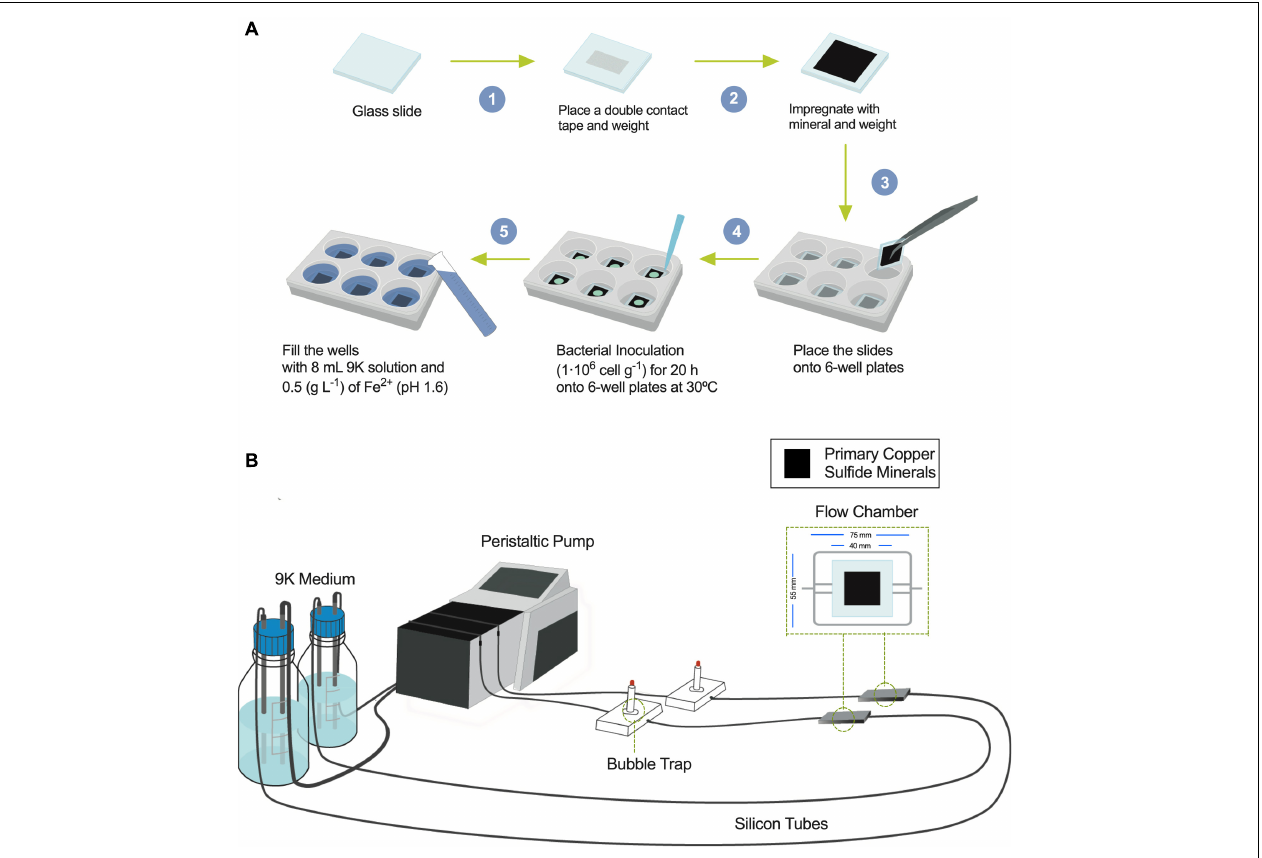
FIGURE 1 | Diagrams showing the flow chamber for biofilm formation and the screening assay under shaking conditions. (A) Screening procedure scheme to bioleach copper from primary copper sulfides in mesophilic conditions (30 ◦ C) under shaking using six-well plates with inoculation of bacterial acidophiles. (B) Flow cell model and assembly diagram of bioleaching copper from primary copper sulfides under laminar regimes and buildup biofilm composed of acidophilic bacterial consortium growing at 30 ◦